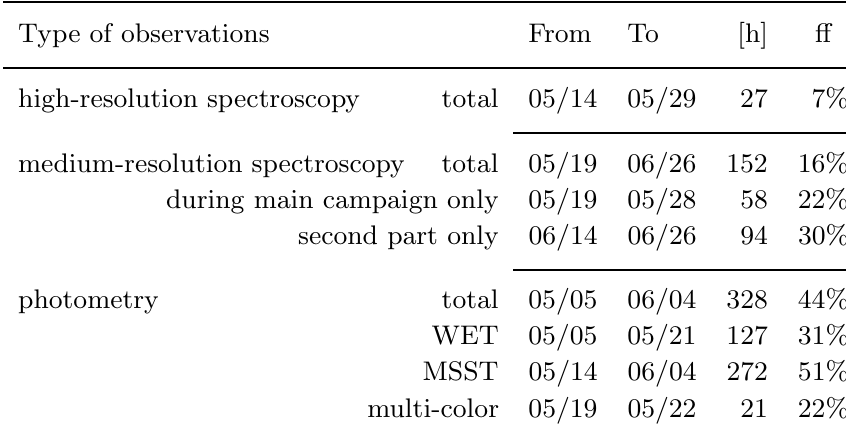
Table 1. Overall data in 2002; ff – filling factor. Type of observations From